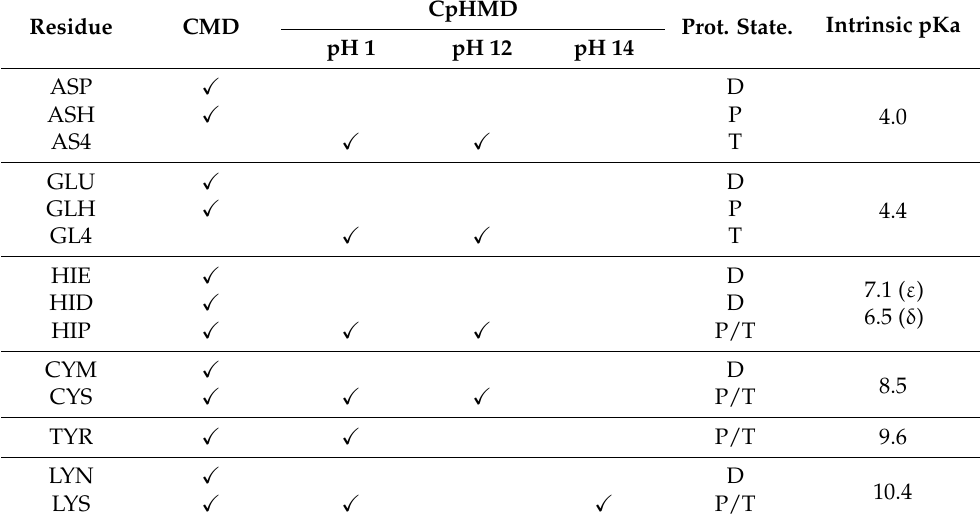
Table 1. Simulations performed per each residue type and methodology. Protonation state is defined as deprotonated (D), protonated (P) or titratable (T) form. Some residues can be used to build protonated conventional Molecular Dynamics (CMD) simulations as well as titratable Constant pH Molecular Dynamics (CPHMD) systems. AMBER’s intrinsic pKa values are used according to Mongan et al.